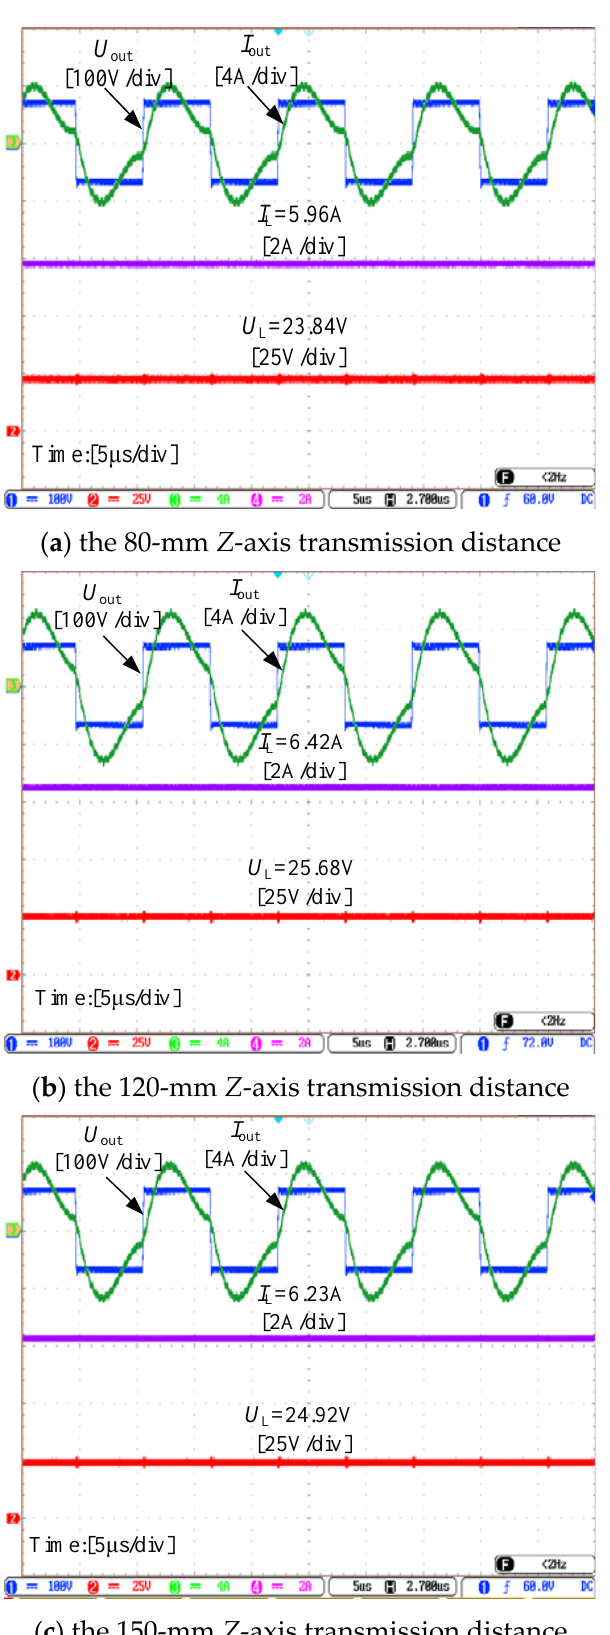
Figure 14. Experimental waveforms of U out , I out , U L , and I L for one-quarter load with R L = 4 Ω .